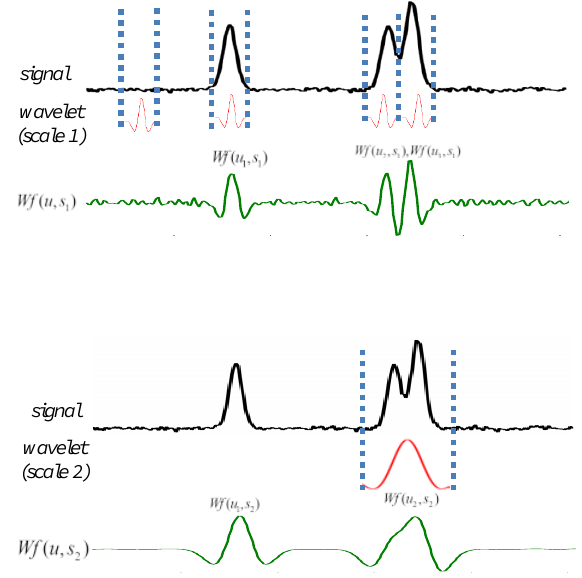
Figure 2. the interpretation of detecting echoes by